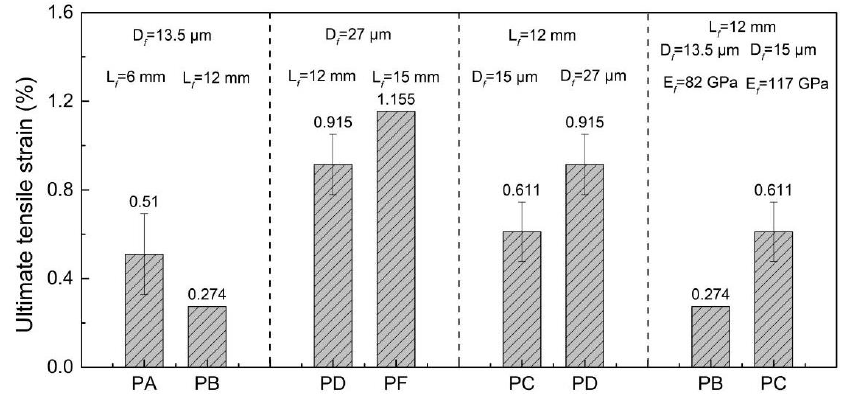
Figure 11 . Comparison of the ultimate tensile strain of different specimens. Figure 11. Comparison of the ultimate tensile strain of different